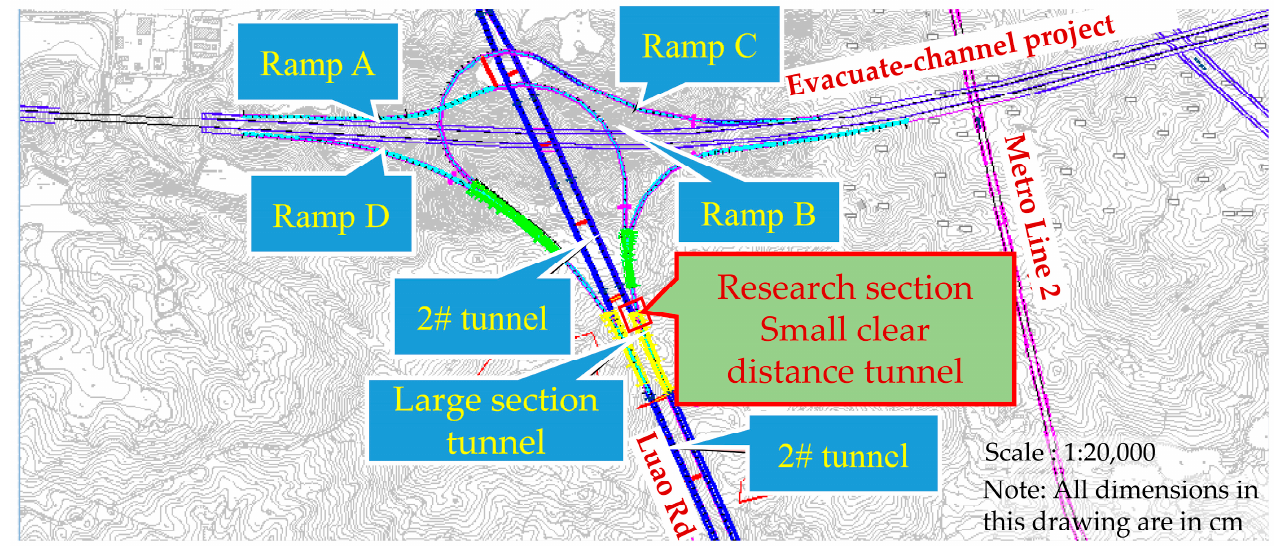
Figure 3. Research section